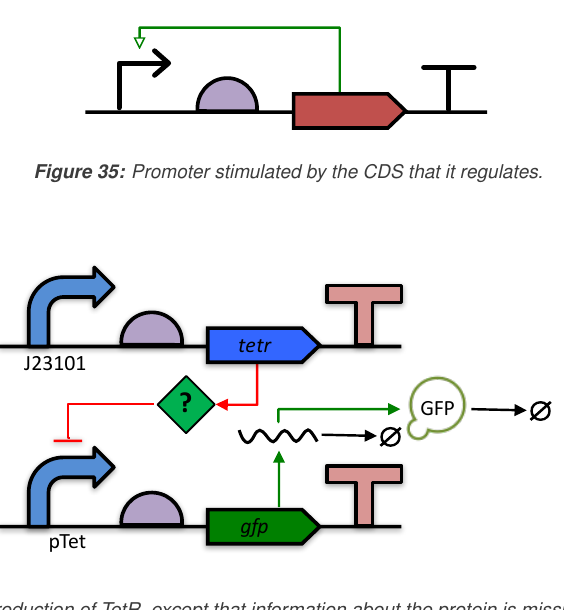
Figure 36: Constitutive production of TetR, except that information about the protein is missing, leaving it as the default unspecified glyph. TetR represses the pTet promoter, which is regulating production of GFP. The diagram of GFP production explicitly includes the intermediate mRNA and the degradation of both the mRNA and protein products.